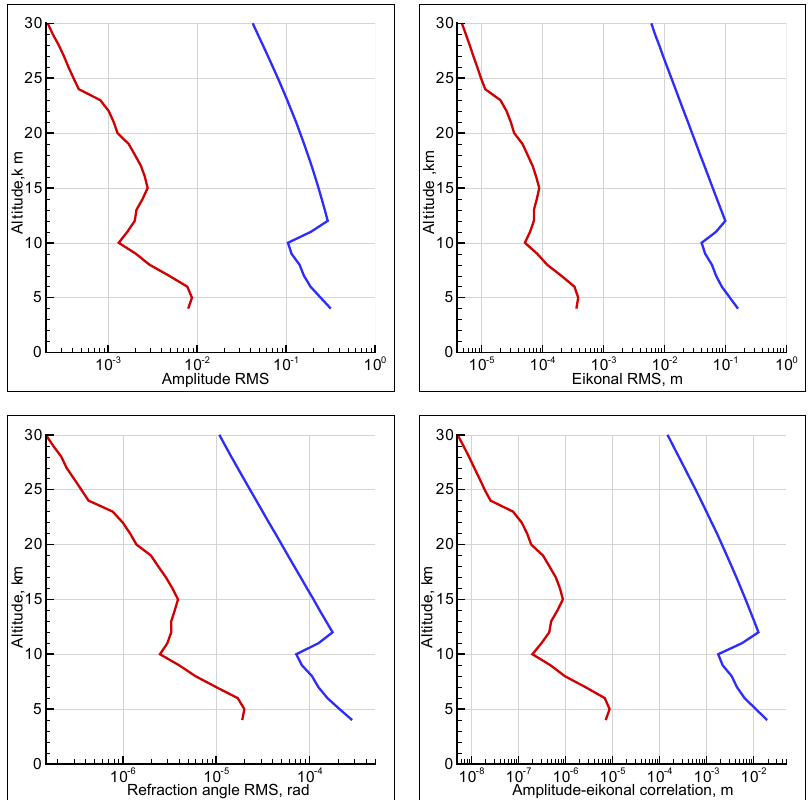
Figure 1. RMS fluctuations of logarithmic amplitude, eikonal, incident angle, and single-point correlation of logarithmic amplitude and phase for the model of saturated IGWs (blue lines) and for the model of turbulence (red